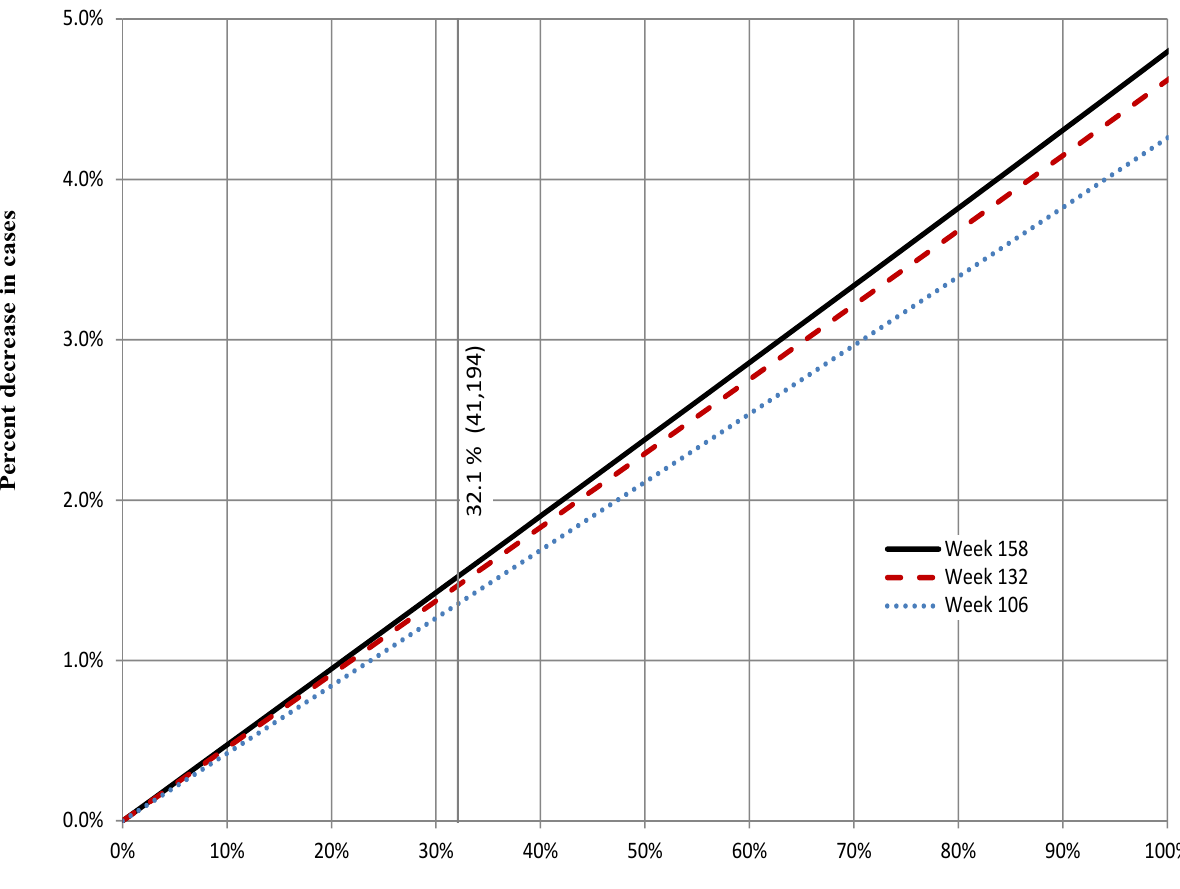
Figure 12. Artibonite. The percent decrease in the total number of cases at Weeks 100, 125 and 150 for the percent of the non-symptomatic core group vaccinated indicated on the abscissa. The onset of the immune response was assumed to begin in Week 81 and complete in Week 85. We assume 70% efficacy of the vaccine. The actual number completing vaccination (41,194) is indicated by the vertical